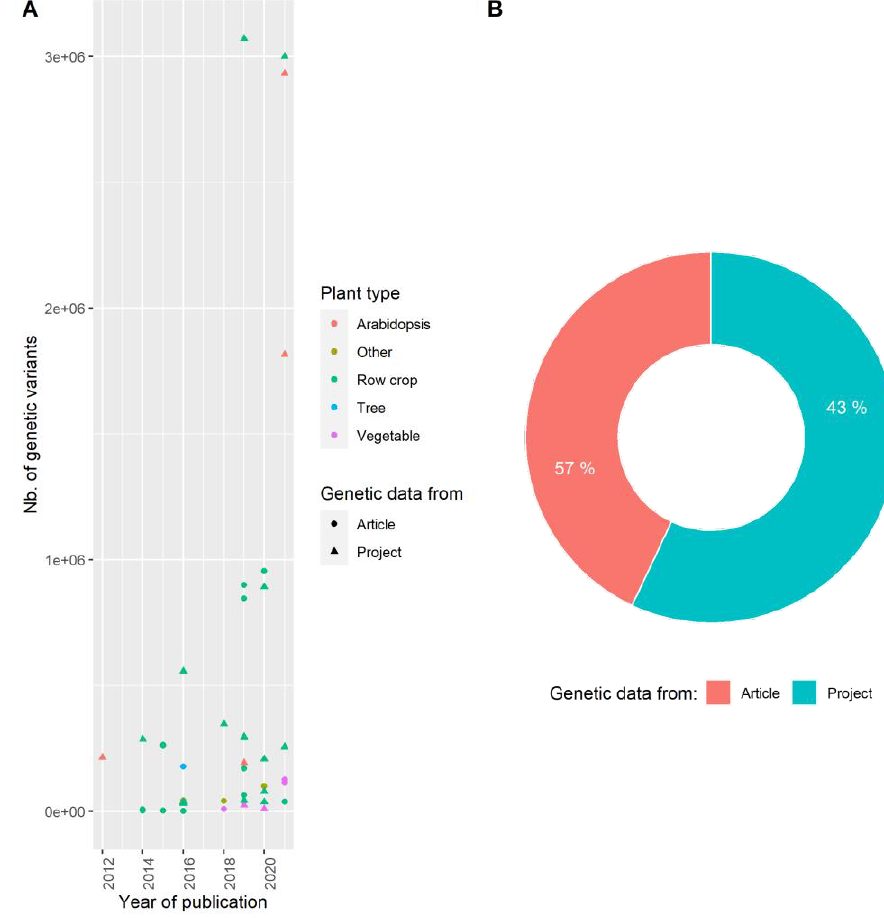
Figure 4. The genotypic variants in plant–virus GWAS: ( A ) Number of genetic variants used to map plant resistance to virus via GWAS in studies published since 2012; ( B ) Proportion of plant–virus GWAS articles which genotyped the diversity panel versus articles using already available genotypic data.